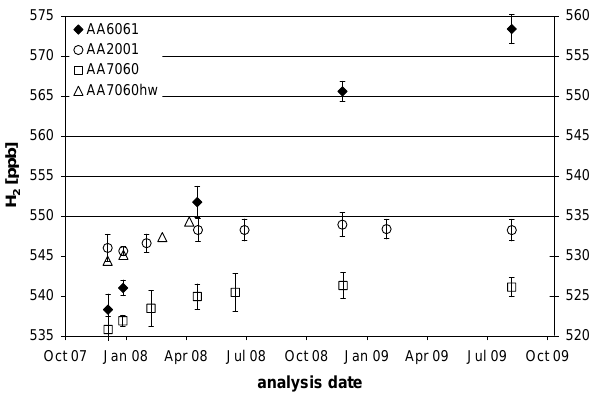
Fig. 4. Time series of quality control standard gas analysis results. Figure 4. Time series of quality control standard gas analysis results 2